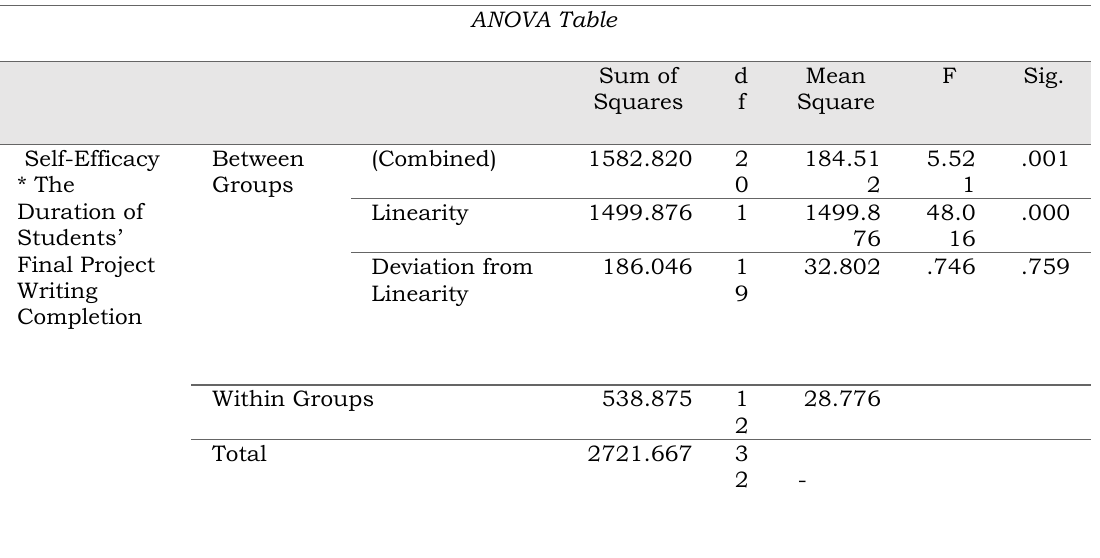
Table 5. Test of linearity ANOVA Table Sum of